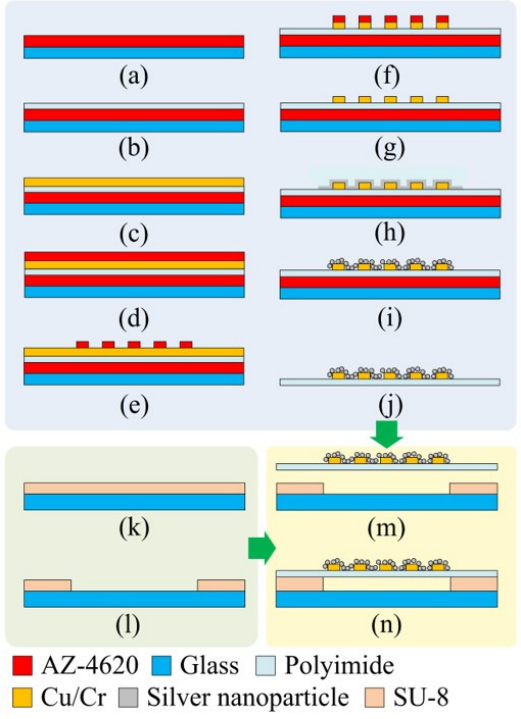
Figure 3. The fabrication process of the proposed device.